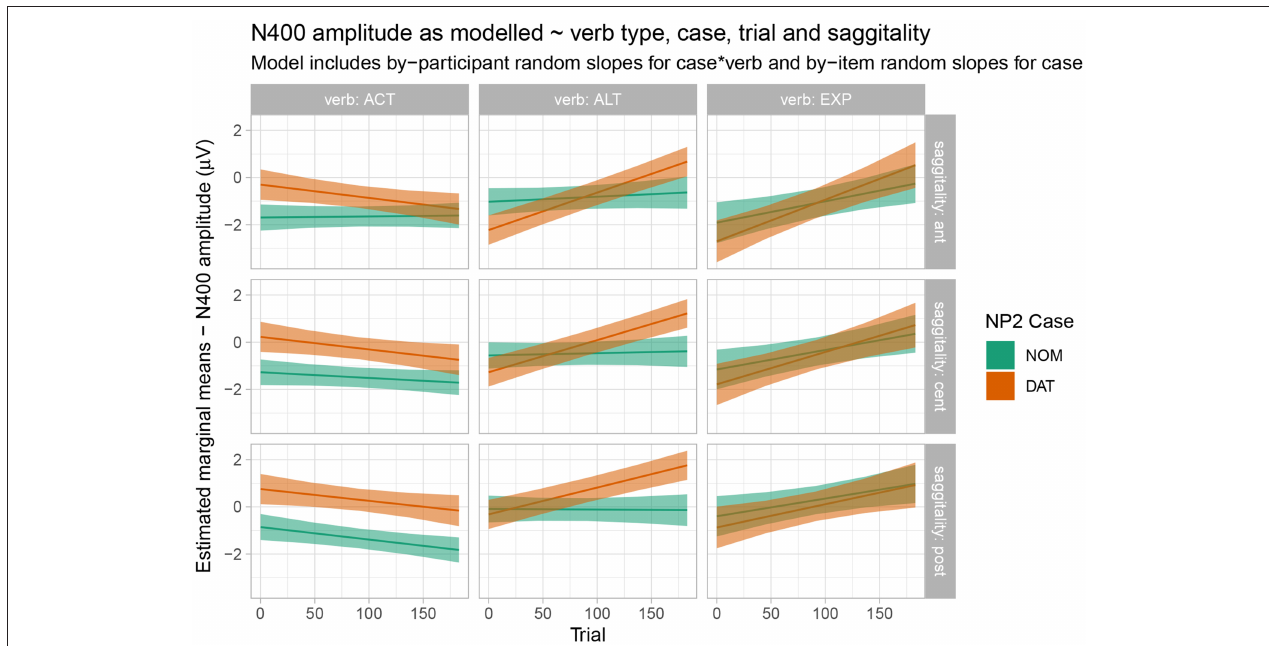
FIGURE 6 | Estimated marginal means for the N400 time window by verb type, case, epoch, and saggitality. Shaded regions indicate 83% confidence intervals.